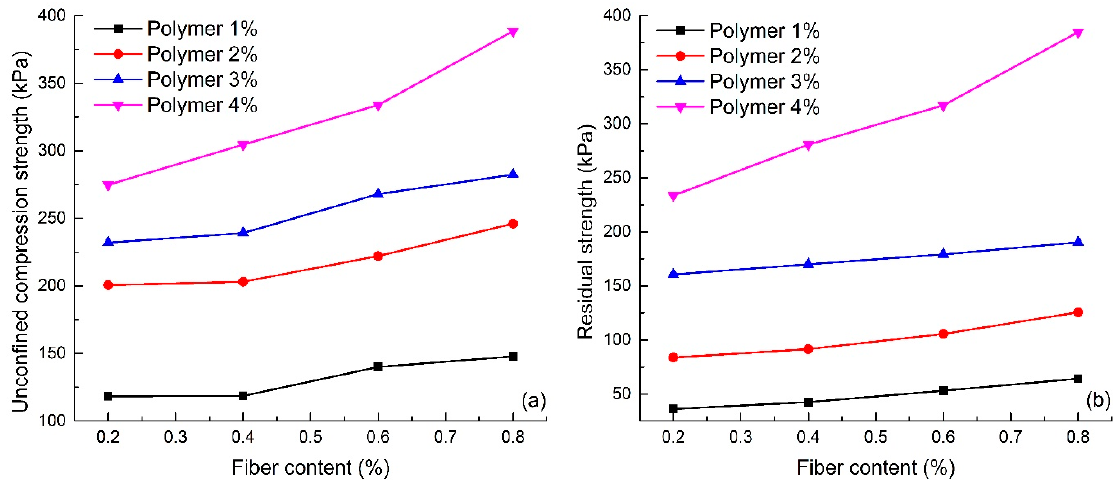
Figure 6. Effect of fiber content on unconfined compression test: ( a ) Unconfined compression strength; ( b ) Residual strength.